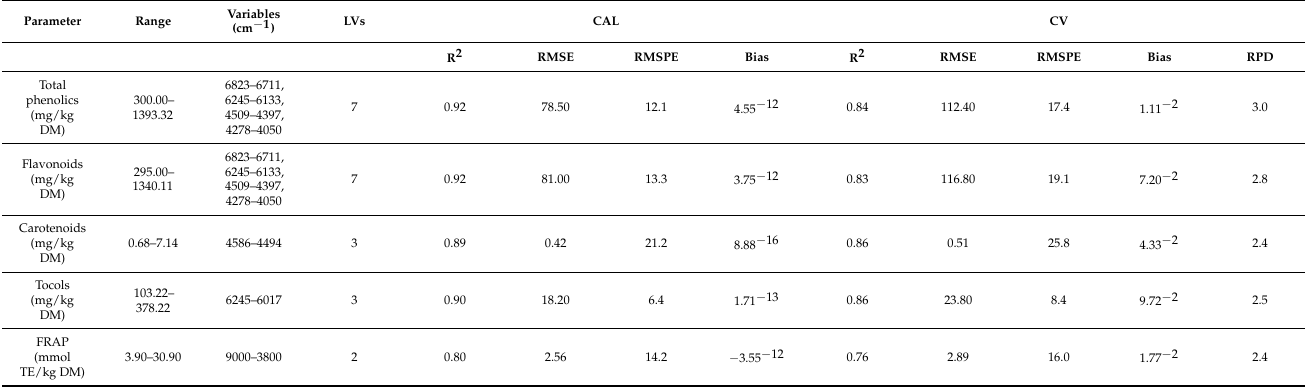
Table 4. Prediction performance of PLS regression